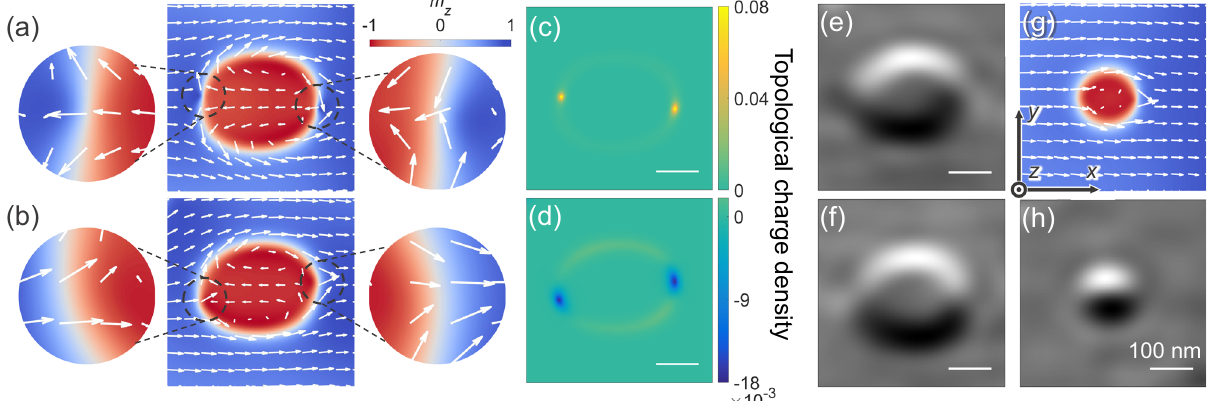
Fig. 2 Spin textures of biskyrmions and bubbles and corresponding TEM images. a , b The spin texture of a biskyrmion slightly below the middle plane of the fi lm and a bubble at the middle plane of the fi lm, respectively. The arrow represents the in-plane magnetization m xy . c , d The distribution of topological charge density per unit cell, i.e., the integrand in Eq. (2), of the spin textures in a and b , respectively. g The bubble transformed from the biskyrmion in a at 0.2 T. The external fi eld is increased with steps of 0.02 T, and the state is relaxed in every step. The magnetic easy axis lies in the xz-plane. e , f , h The corresponding Lorentz TEM images of a , b , g , respectively. Calculation is performed with magnetization averaged through the thickness at a defocus of 1.6 mm 36